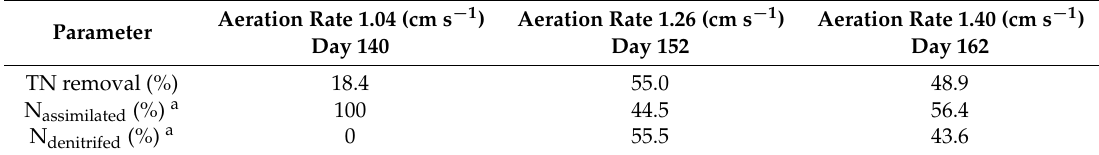
Table 3. Nitrogen removal efficiencies in SBR III operated with three different upflow gas velocities.